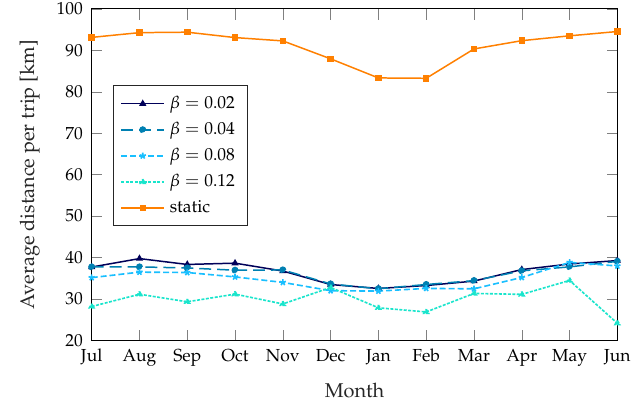
Figure 6. Average distance per rebalancing trip, plotted over 12